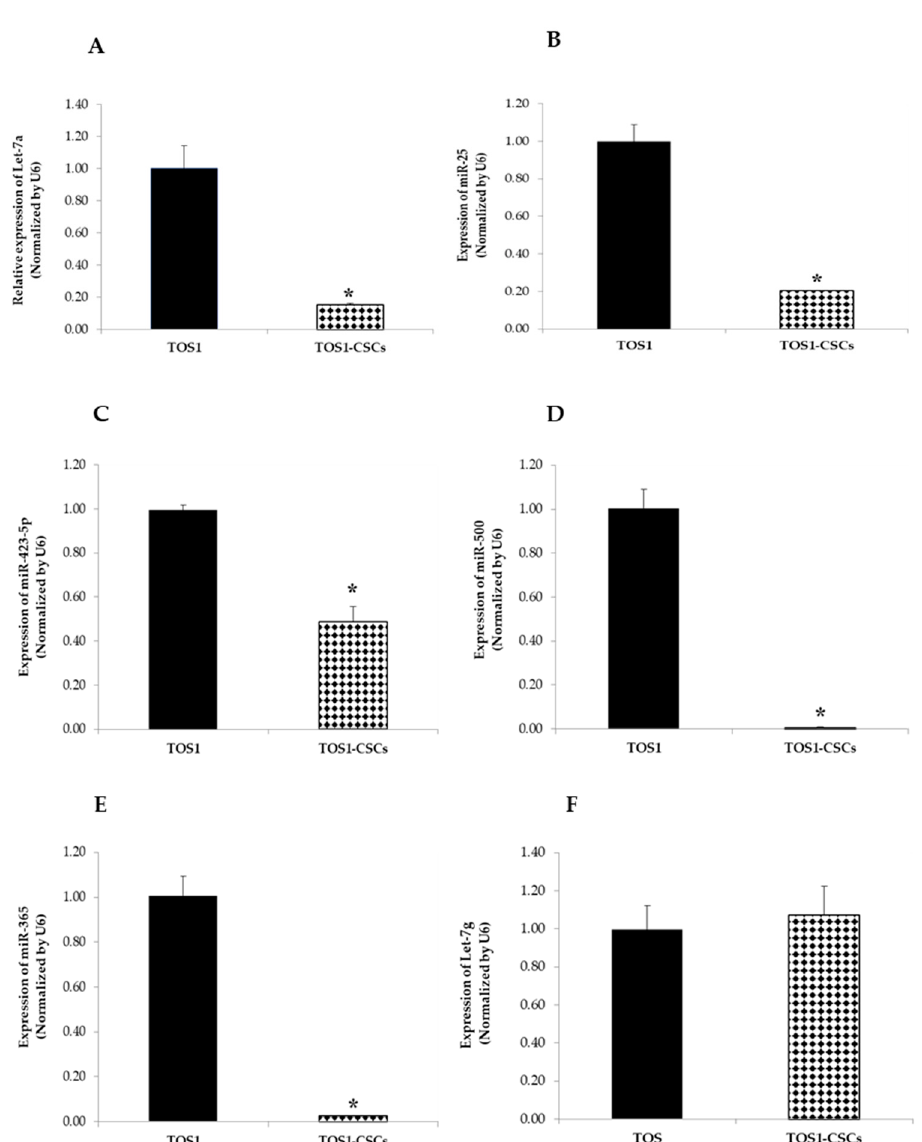
Figure 13. Expression levels of four miRNAs in the TOS1-CSC line. RT-qPCR analysis of expression of Let-7a ( A ), miR-25 ( B ), miR-423-5p ( C ), miR-500 ( D ), miR-365 ( E ) and Let-7g ( F ) were examined by real-time RT-PCR analysis in both TOS1 cell line and isolated TOS1-CSC cell line. Data represent the mean with standard deviation ( n = 4); * p < 0.001 as compared to TOS1 cell line.